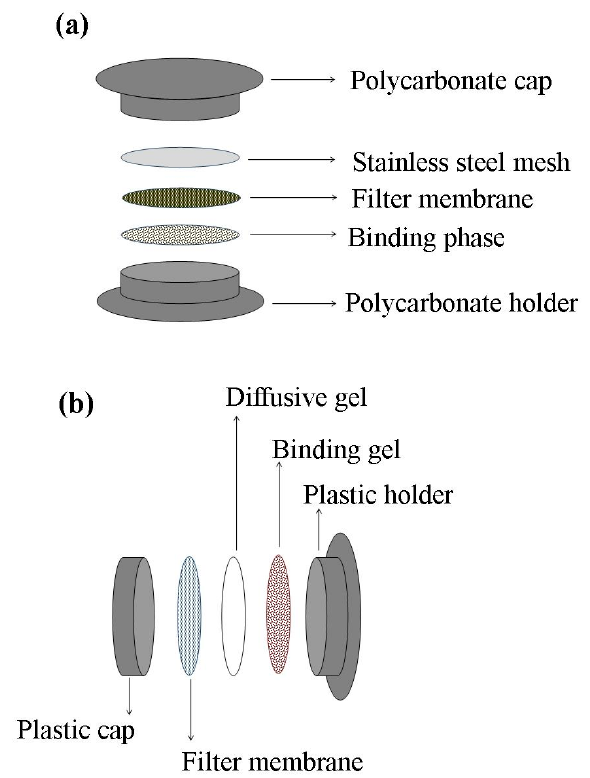
Figure 5. Components of ( a ) Chemcatcher ® and ( b ) diffusive gradient in thin-films passive samplers (adapted from Gong et al., [76]).